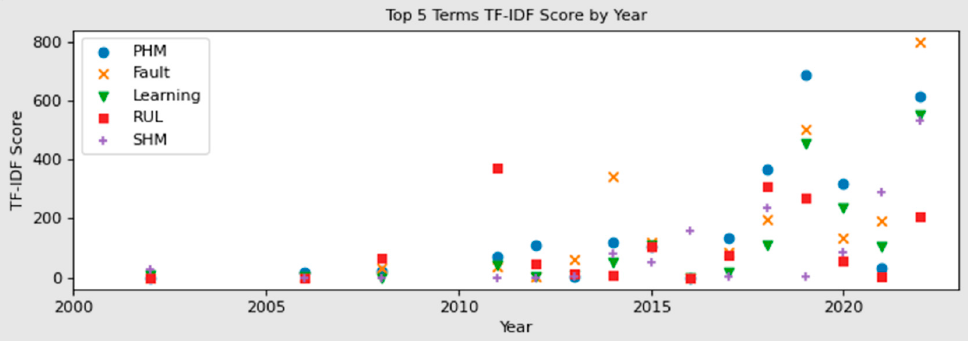
Figure 3. TF-IDF scores for the top five terms across the fifty review papers grouped by year.